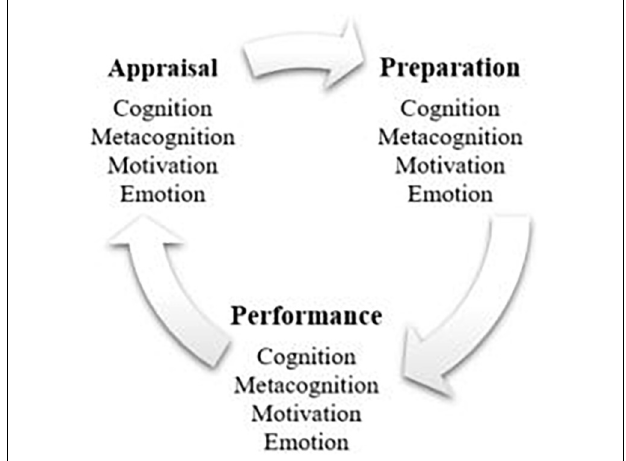
FIGURE 1 | Cyclical model of Self-regulated learning (SRL) adapted from Panadero (2017).